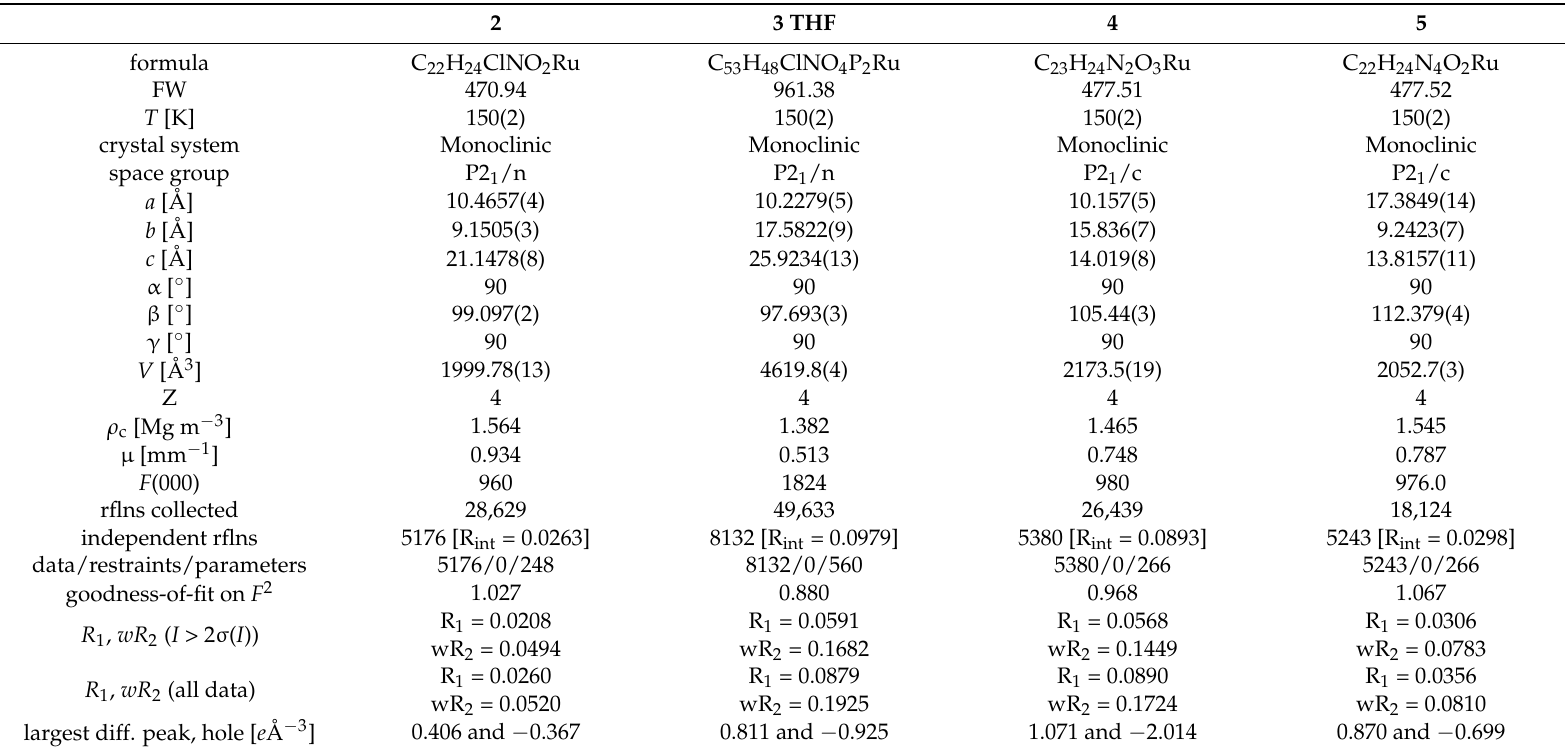
Table 1. The summary of X-ray crystal data for Compounds 2 –